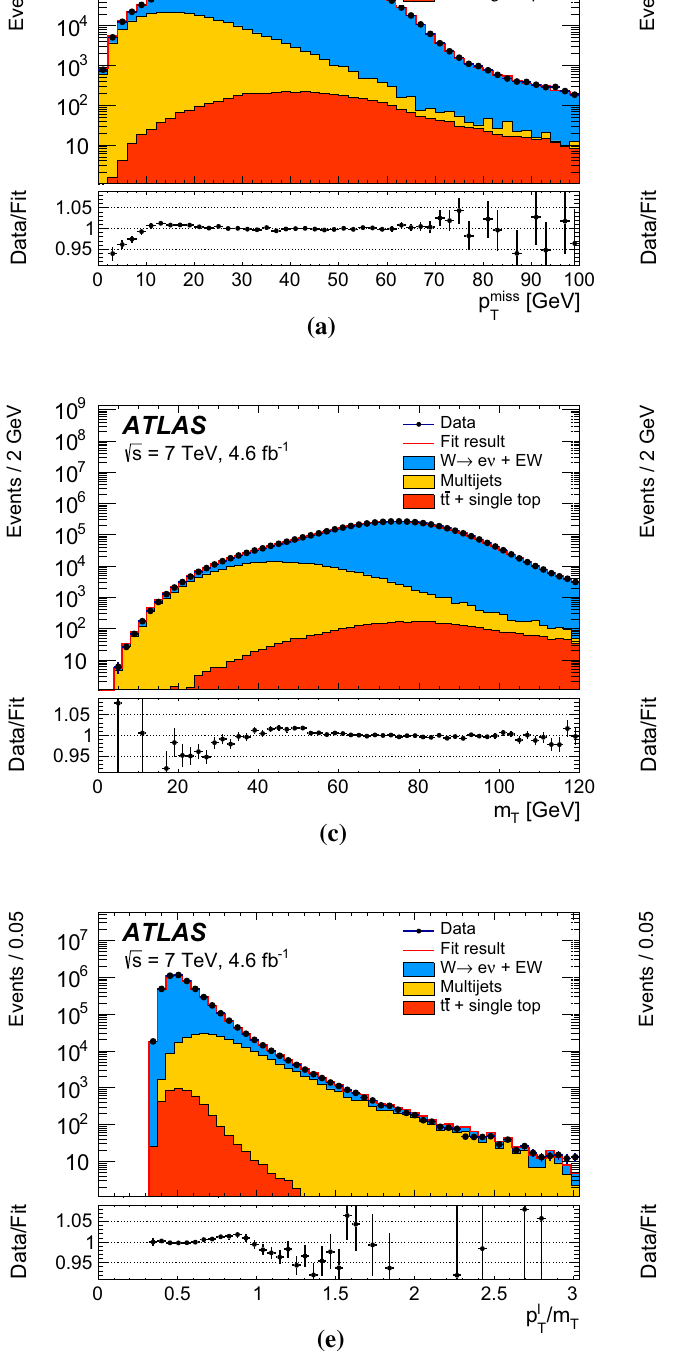
Fig. 17 Example template fits to the a , b p miss / m p (cid:7) T distributions in the FR1 kinematic region, in the a , c , e electron T and b , d , f muon decay channels. Multijet templates are derived from the data requiring 4GeV < p e , cone